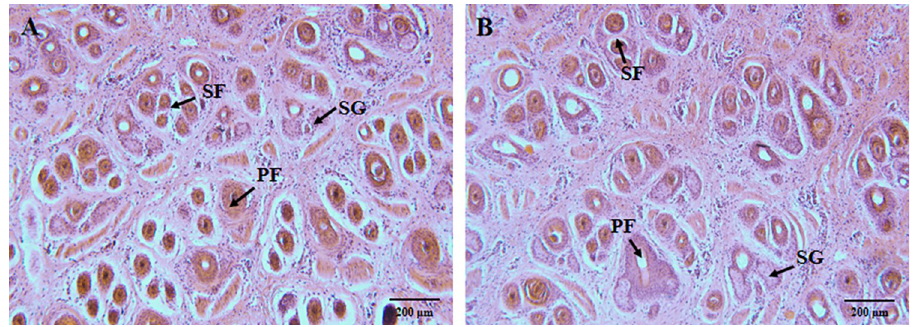
Fig 2. Skin morphology of the Hetian sheep with high and low wool density (100 × ). (A) Cross-sections of the sheepskin in the HS group. (B) Cross-sections of the sheepskin in the HP group. PF: primary hair follicle; SF: secondary hair follicle; SG: sebaceous gland.